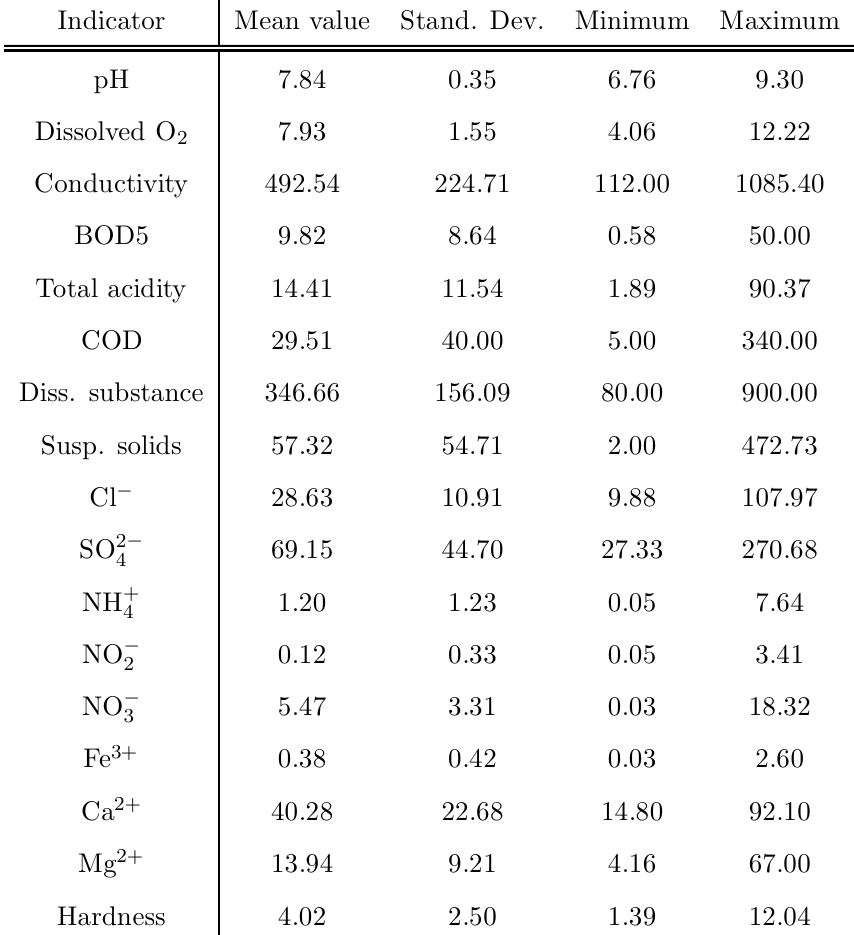
Table 1 Basic Descriptive Statistics (concentrations in mg/dm 3